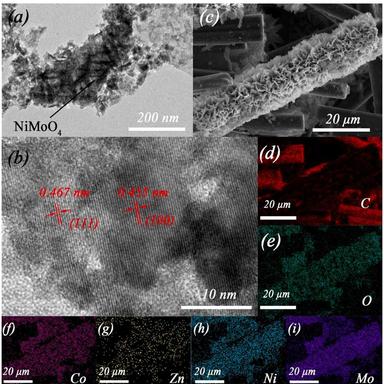
(a) TEM image of ZnCo2O4@NiMoO4 composite; (b) HRTEM and (c-i) corresponding mapping result.